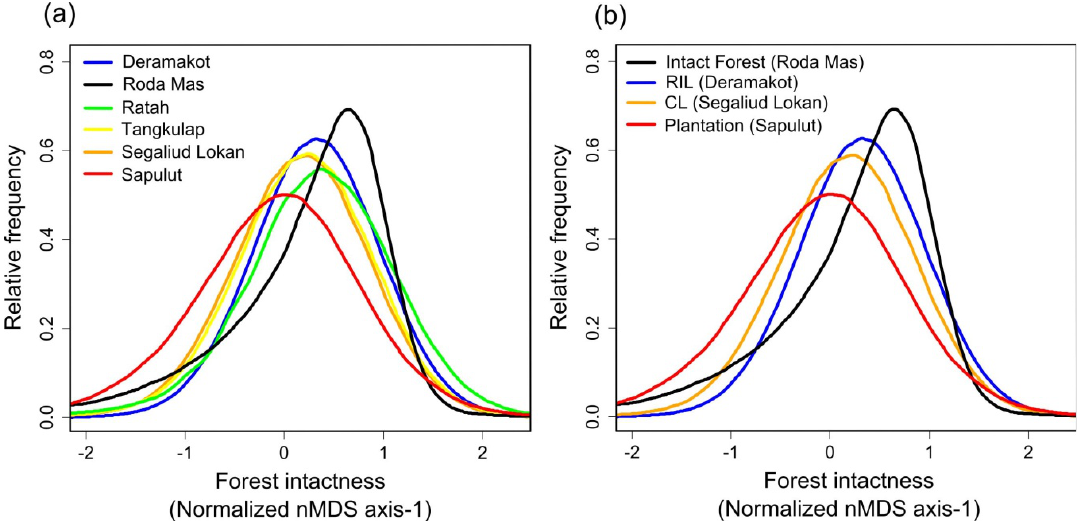
Figure 4. Histograms of normalized nMDS (non metric multidimensional scaling) axis-1 scores ( a ) in all FMUs, and ( b ) in four selected FMUs. (RIL, reduced-impact logging; CL, conventional logging).